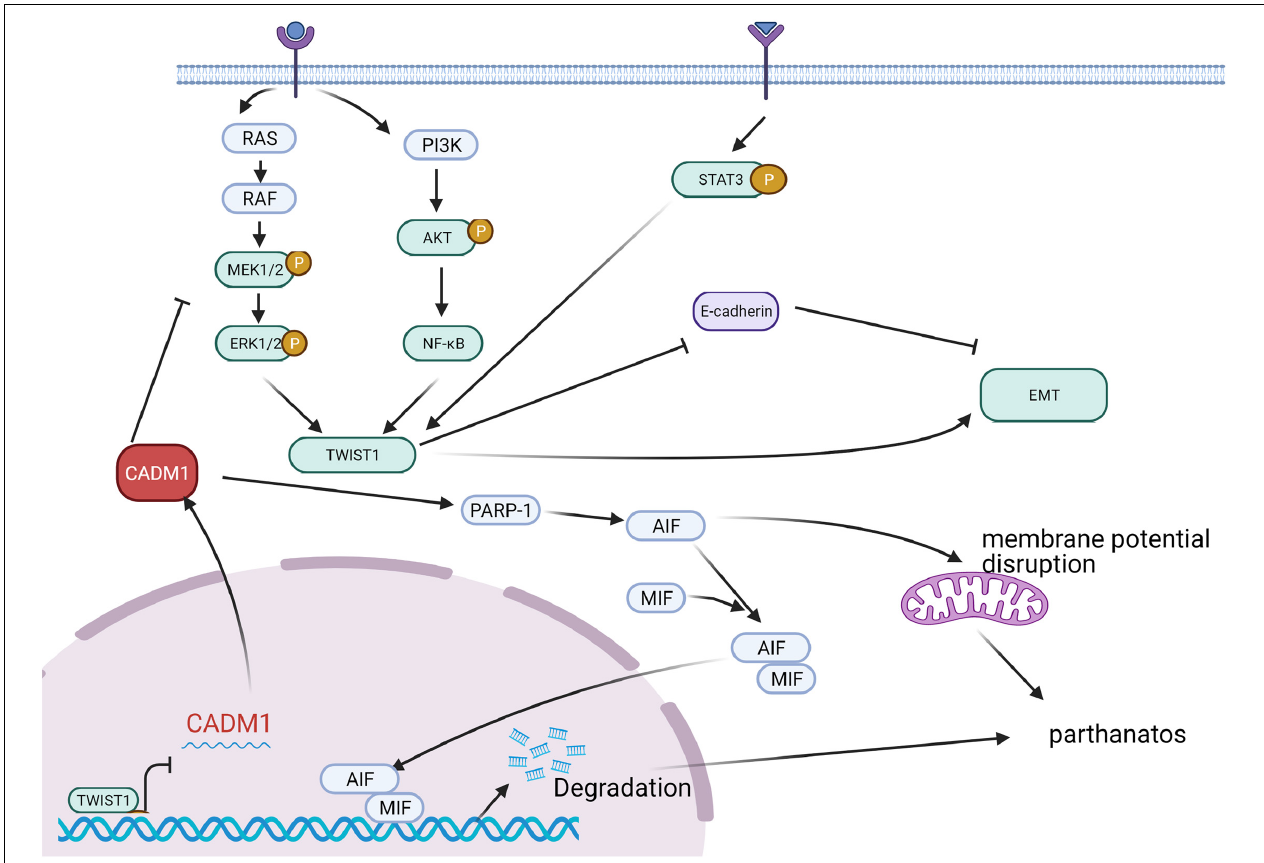
FIGURE 2 | In malignant melanoma, extracellular stimulus signals are transmitted into cells through receptors on the membrane and can activate TWIST1 through RAS-RAF-MEK1/2-ERK1/2, PI3K-AKT-NFKB, and STAT3 pathways, respectively. TWIST1 can inhibit E-cadherin and promote the process of EMT. CADM1, generally highly expressed, can inhibit the activation of TWIST1 by inhibiting the RAS-ERK pathway and then inhibit the EMT process. CADM1 can increase PARP-1 (poly ADP ribose polymerase) and recruit AIF (mitochondrial apoptosis inducing factor) and MIF (microphage migration inhibitory factor) to the nucleus, breaking down DNA into large fragments, and promoting cell death or inducing the destruction of mitochondrial membrane potential, leading to cell-dependent cell death. That is to say, elevated CADM1 can inhibit invasion and migration by inhibiting the EMT process or inducing cell death under non-adhesive